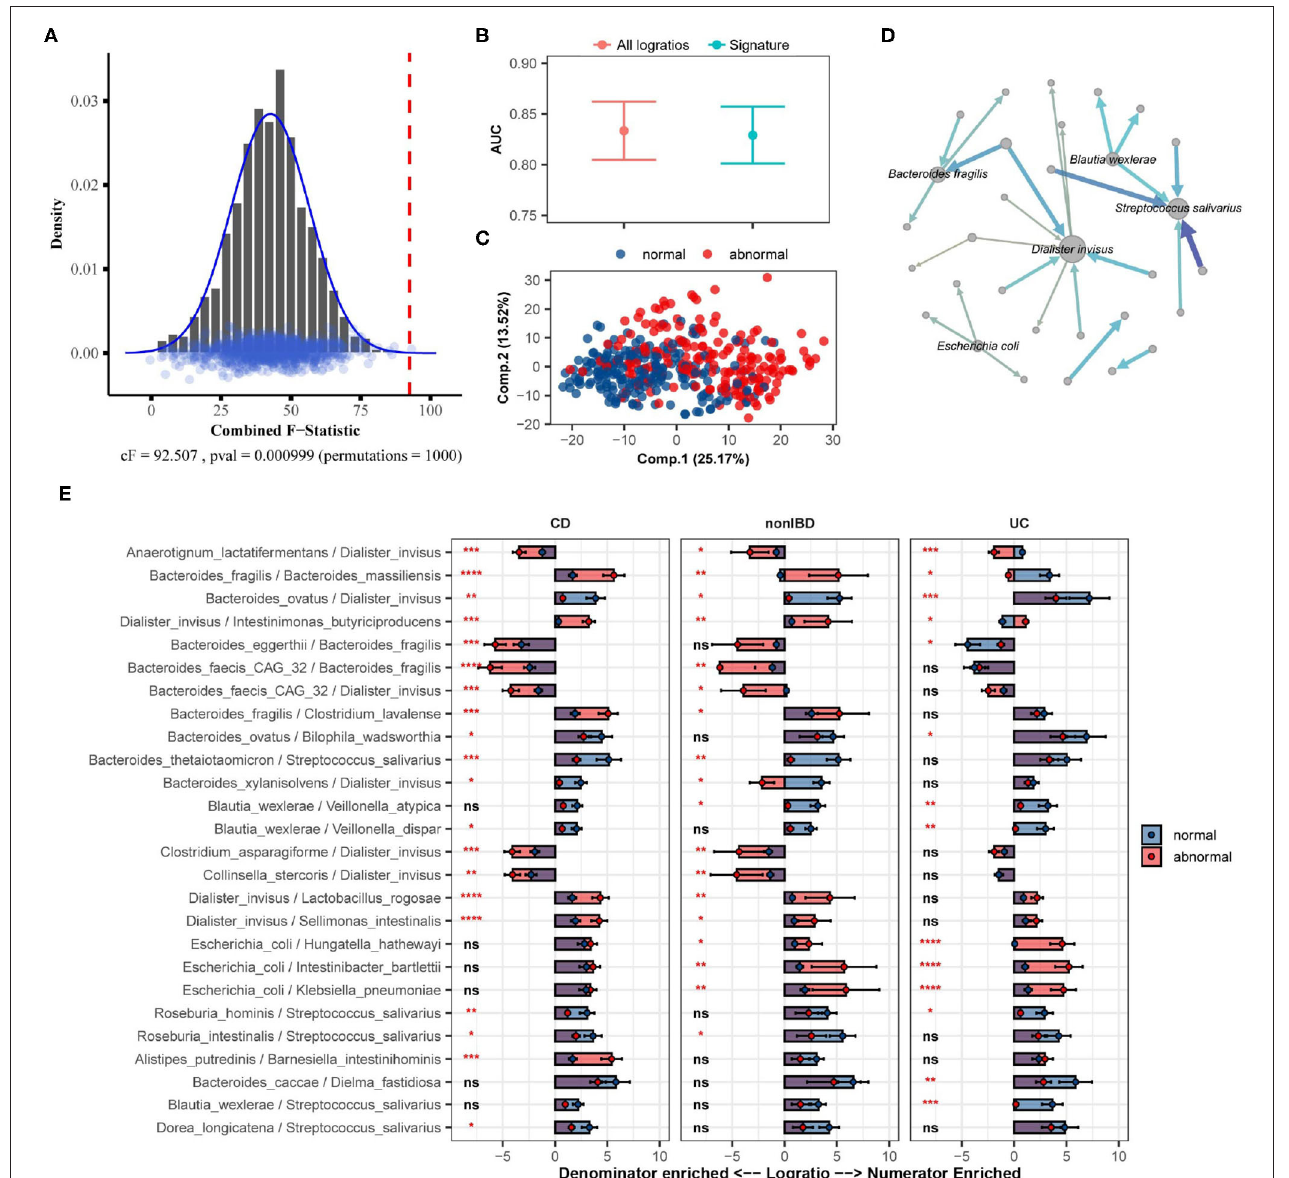
FIGURE 7 | SelEnergyPerm case study examining the association between abnormal fecal calprotectin levels and the gut microbiome composition in nonIBD and IBD individuals using WGS data. (A) SelEnergyPerm permutation test results displaying the null distribution of the cF statistic (Histogram, Density, and Points) and the empirical cF statistic (dashed red vertical line). (B) AUC comparisons of fecal calprotectin level (Abnormal/Normal) discrimination using PLS-DA with 2 components. Models were trained with repeated ( r 20) 10-fold cross-validation using either the SelEnergyPerm signature or all logratios. Points represent the mean AUC and error = bars indicate the 95% CI. (C) PLS-DA latent space projection plot extracted from final PLS-DA model fit using the full dataset with the SelEnergyPerm signature. Points represent non-IBD or IBD samples. (D) Directed network (edges point from numerator to denominator) of the SelEnergyPerm-selected logratio signature (nodes taxa, node size DCV strength, edges logratio, edge width/color PLS-DA Variable Importance). The top 5 taxa names by strength (PLS-DA Variable = = = = Importance) are displayed. (E) Logratio means comparison (normal/abnormal fecal calprotectin level) of each logratio included in the SelEnergyPerm signature stratified by Crohn’s Disease (CD), Ulcerative Colitis (UC), and non-IBD individuals. Significance codes (ns, *, **, ***, ****) indicate BH corrected (within diagnosis) p-value < (Not Significant, 0.05, 0.01, 0.001, 1e-4, 0) for normal vs. abnormal Wilcoxon Rank Sum Test. Error bars indicate the 95% CI of the mean. Notably, error bars that do not span 0 indicate numerator/denominator is on average more abundant than the opposite.